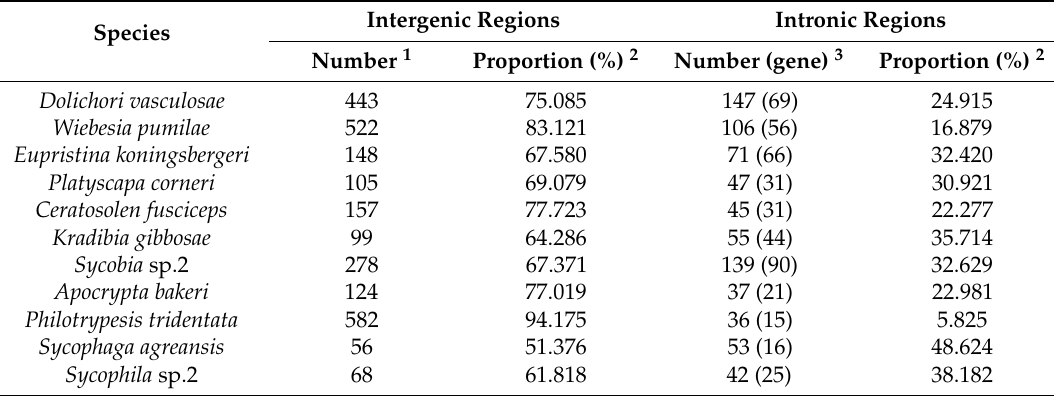
Table 1. The insertion sites of NUMTs in the fig wasp genomes.